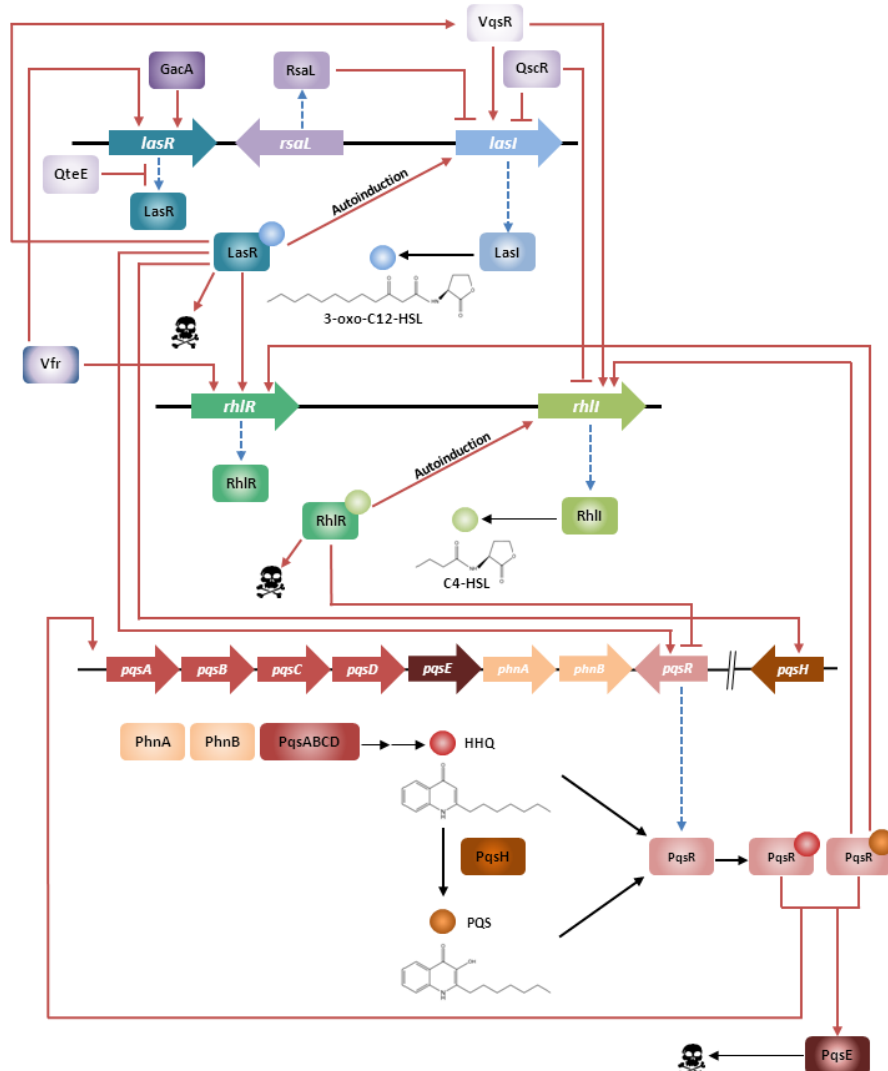
Figure 1. Quorum sensing (QS) in Pseudomonas aeruginosa . The hierarchical organisation of the two AHL-dependent QS systems in P. aeruginosa and its correlation with the P. aeruginosa quinolone signal (PQS) system is presented in the scheme below. (Skull represents virulence factor